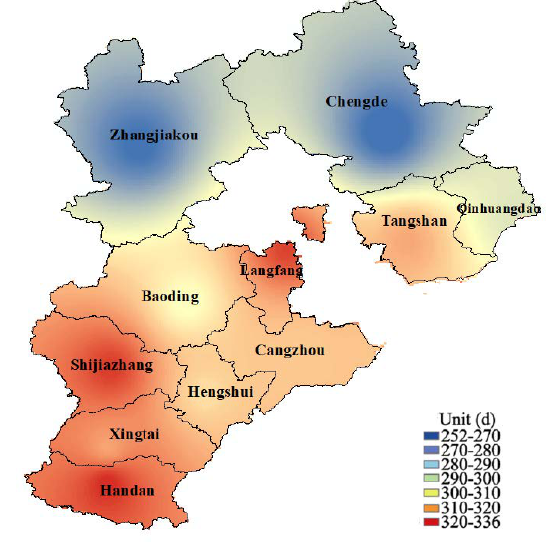
Fig. 2 Spatial distribution of comprehensive rainfall intensity grades in Hebei Province from 08:00 on July 18 to 08:00 on July 21,